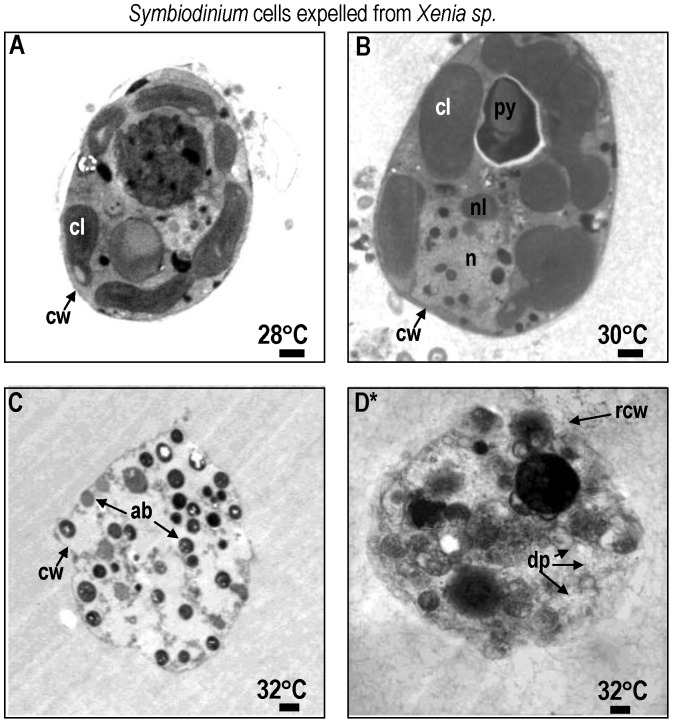
TEM of Symbiodinium cells lost from Xenia elongata at temperatures of 28 to 32°C. Most Symbiodinium cells appeared normal at 28°C (A).Symptoms of cell death become evident at 30°C as organelles move to opposing ends of the cell (B). Symptoms of irreversible late stage apoptosis (C) or necrosis (D) occurred at 32°C within 9 h. Symbols: ab = apoptotic body, chr = chromosome, cl = chloroplast, cw = cell wall, gx = glyoxysome, m = mitochondria, n = nucleus, py = pyrenoid, rcw = ruptured cell wall, sg = starch grain. Scale bar = 500 nm.